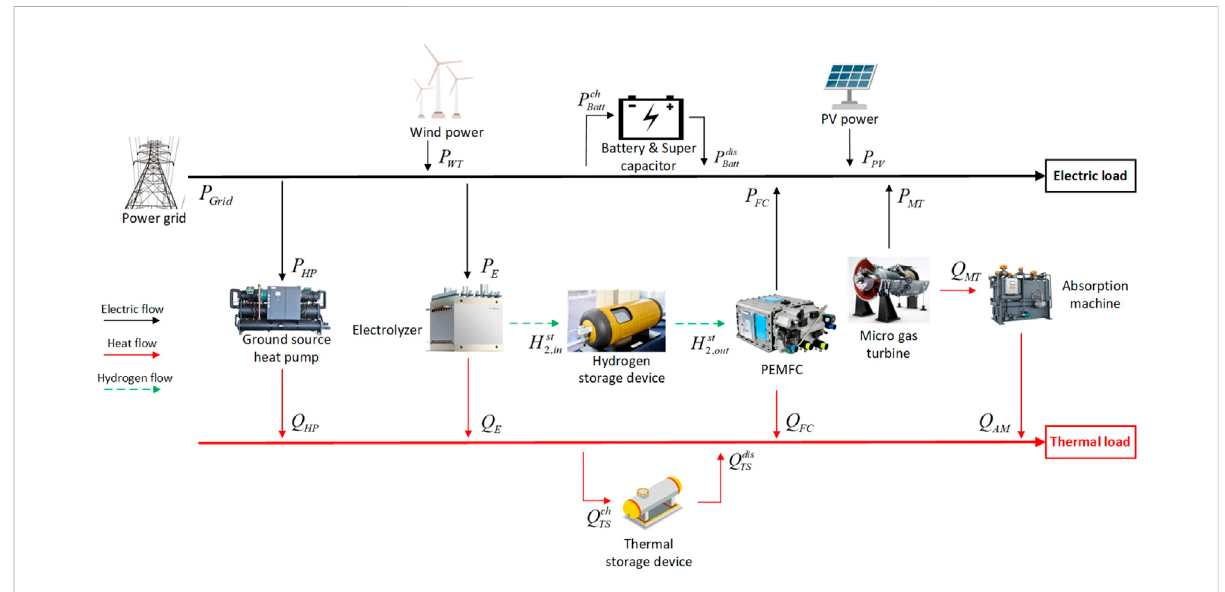
FIGURE 1 Electric-Thermal-Hydrogen integrated energy system